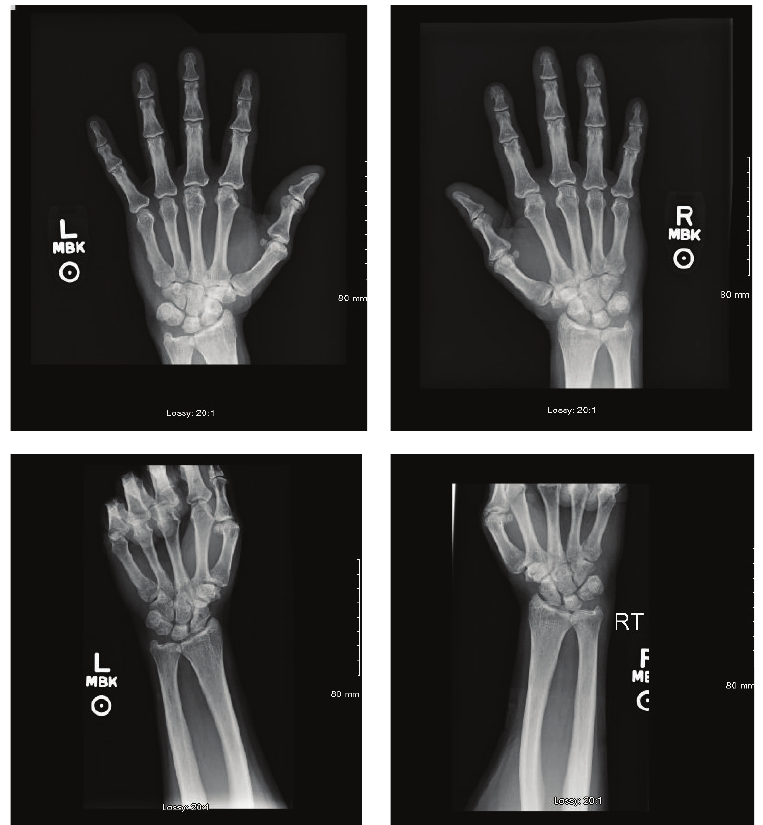
Figure 4: X-ray of the bilateral hands showing early inflammatory